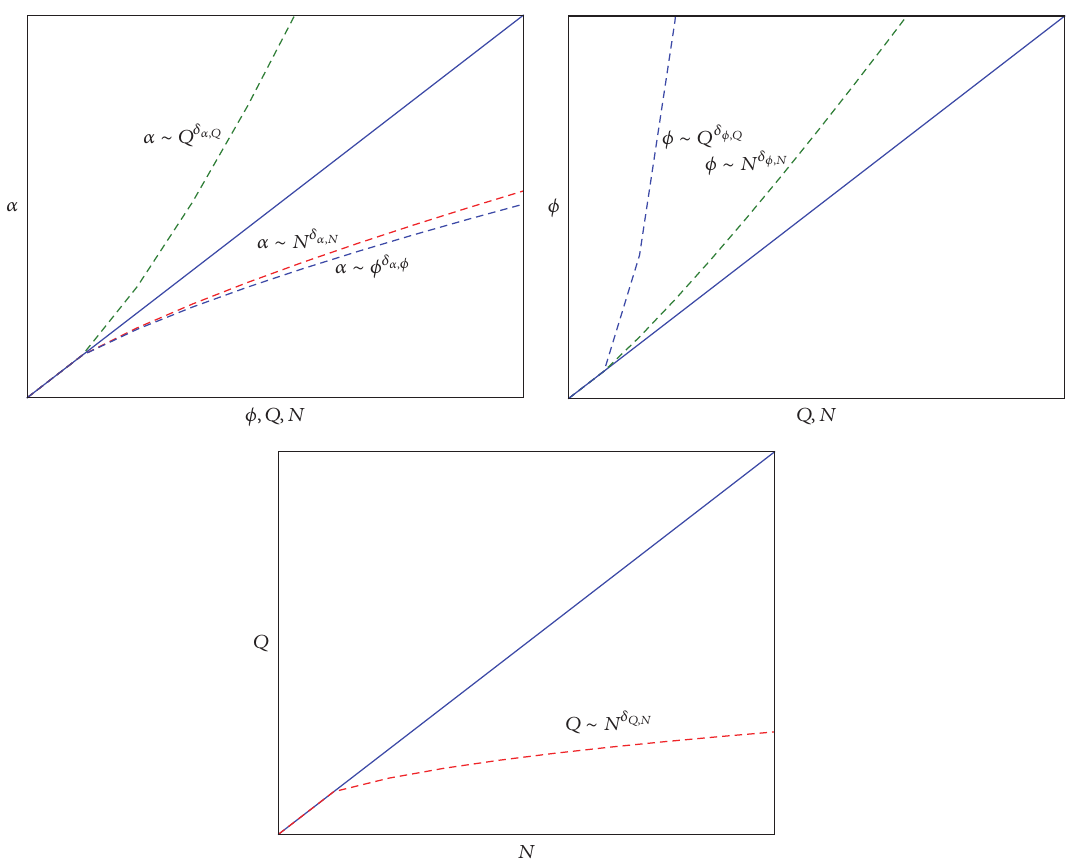
Figure 4: The figure presents a pictorial representation of the power-law scaling relationships between the system variables, 𝛼 , 𝜙 , 𝑄 , and 𝑁 , and the solid diagonal line signifies slope of